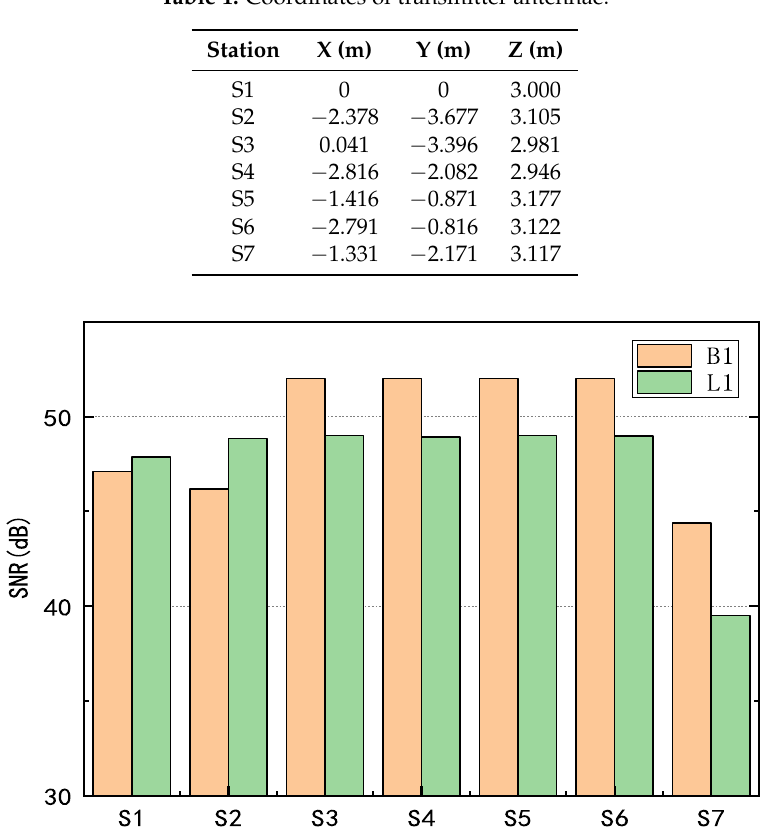
Figure 3. Average SNR (signal-to-noise ratio) values of the